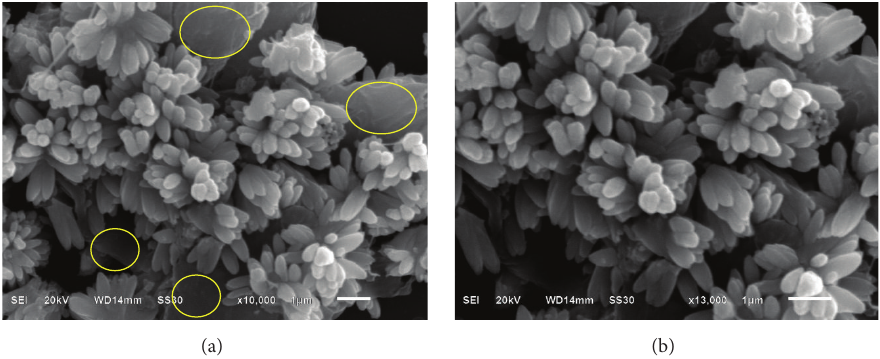
Figure 6: Micrograph of ZnO-SiO 2 using 3.0 M NH 4 OH showing flower-like ZnO-SiO 2 nanostructures having shorter rods and more pronounced hemispherical tips. At (a) 10,000x magnification and (b) 13,000x magnification. Encircled are the flake-like structures.